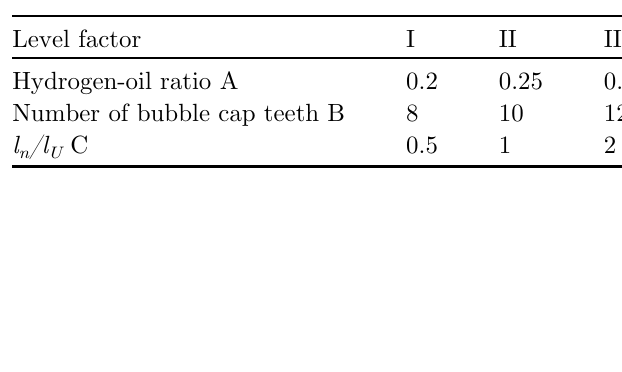
Table 3. Level table of factors for orthogonal test.